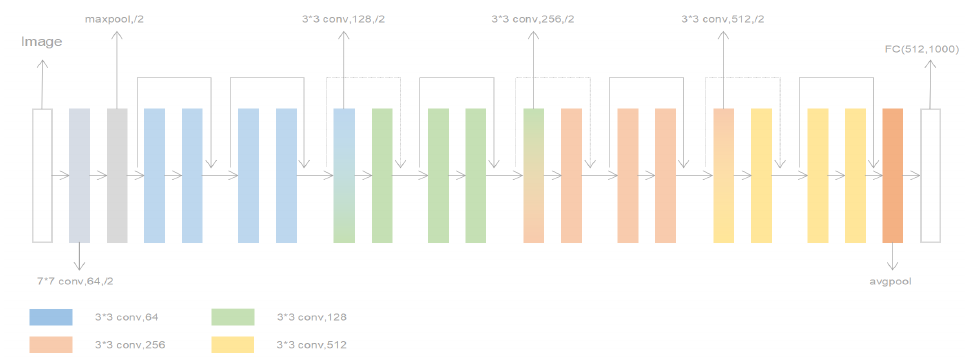
Figure 2. The structure of RESNET18 for ImagNet